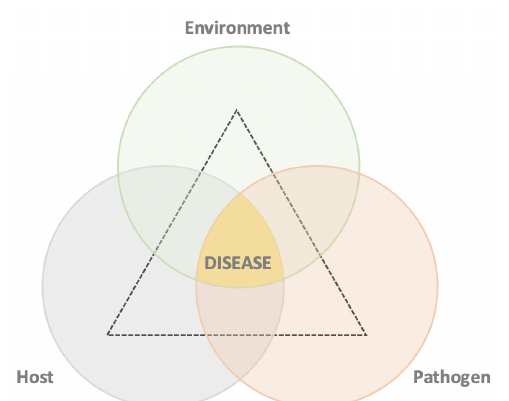
Figure 1. Disease triangle.